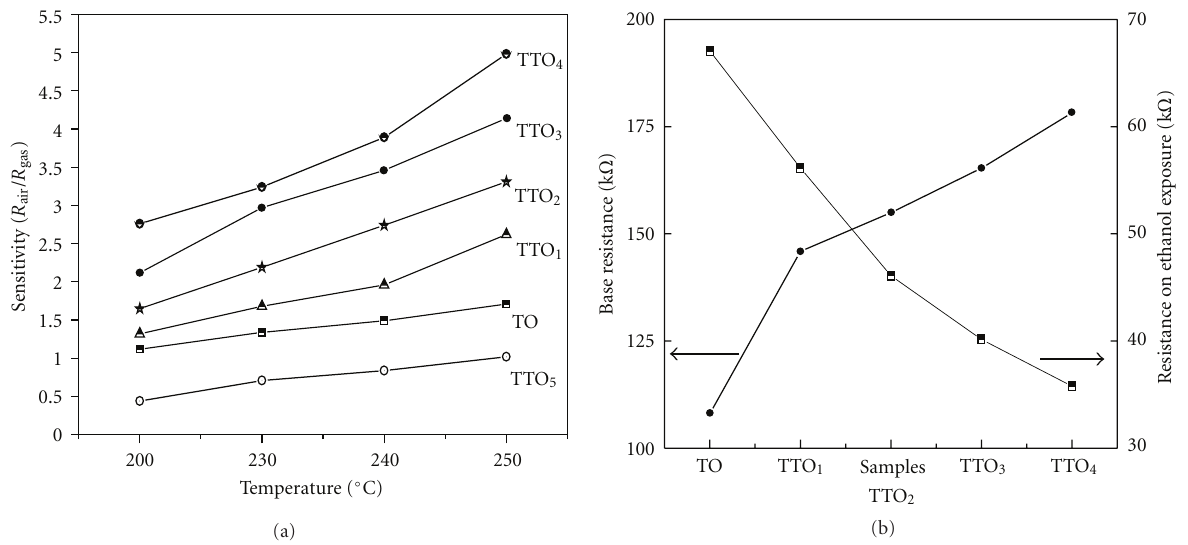
Figure 7: (a) Temperature-dependent sensing response curves and (b) base and sensing resistances dependency to the power of plasma